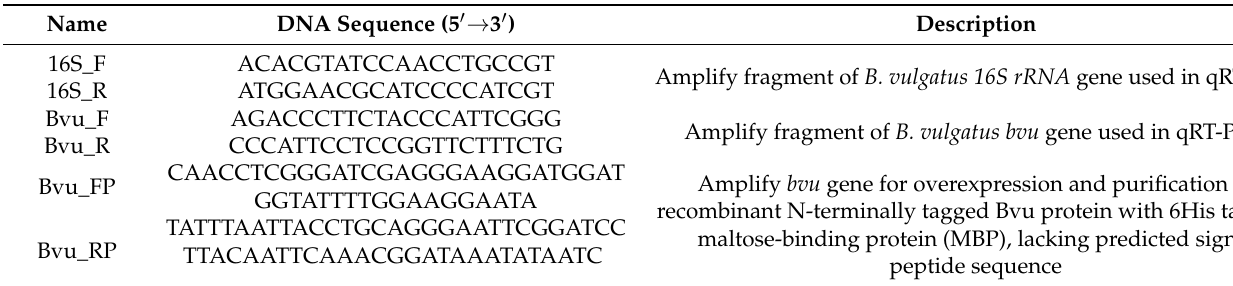
Table 2. Primers designed and used in this